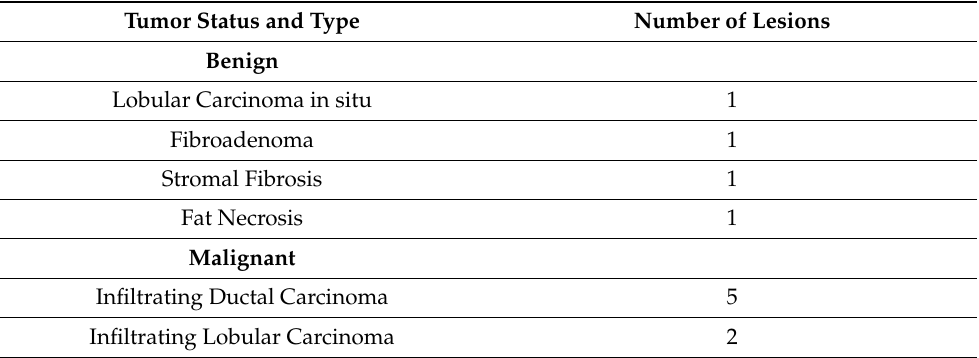
Table 4. Histological results of lesions biopsied.